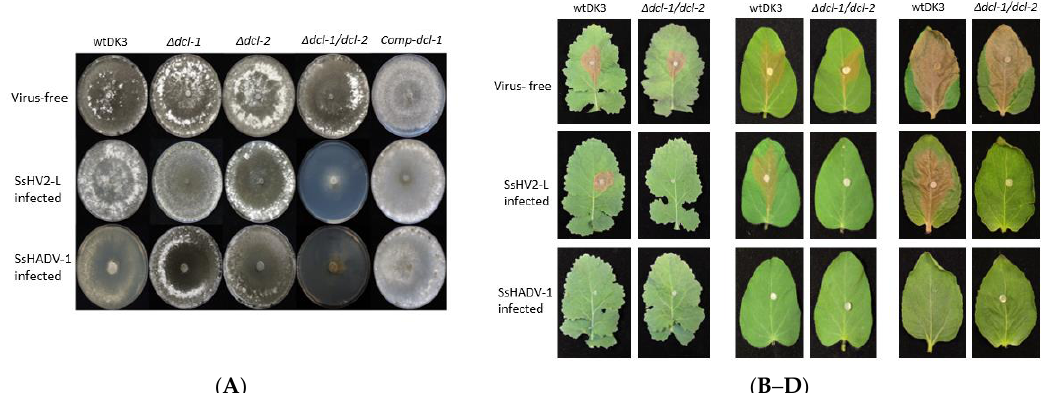
Figure 3. ( A ) Colony morphology of virus-free and virus-infected wild-type, mutant, and strains: (Top row) virus-free wtDK3, ∆ dcl-1 , ∆ dcl-2 , ∆ dcl-1/dcl-2 and Comp-dcl-1 . (Middle row) strains complemented strains: (Top row) virus-free wtDK3, ∆dcl-1 , ∆dcl-2 , ∆dcl-1/dcl-2 and Comp-dcl-1 . infected with hypovirus, SsHV2-L; and (Bottom row) strains infected with SsHADV-1. Cultures were (Middle row) strains infected with hypovirus, SsHV2-L; and (Bottom row) strains infected with grown for seven days on PDA at room temperature. Virulence assays on: ( B ) detached canola leaves; SsHADV-1. Cultures were grown for seven days on PDA at room temperature. Virulence assays on: ( C ) detached soybean leaves; and ( D ) detached sunflower leaves. Plugs were taken from the edge of ( B ) detached canola leaves; ( C ) detached soybean leaves; and ( D ) detached sunflower leaves. Plugs actively growing wtDK3, ∆ dcl-1 (not shown), ∆ dcl-2 (not shown) and ∆ dcl-1/dcl-2 cultures and inoculated were taken from the edge of actively growing wtDK3 , ∆dcl-1 (not shown), ∆dcl-2 (not shown) and onto detached leaves stored at 20 ± 1 ◦ C. Lesion size was measured 36 h ∆dcl-1/dcl-2 cultures and inoculated onto detached leaves stored at 20 ± 1 °C . Lesion size was measured 36 h post-inoculation.